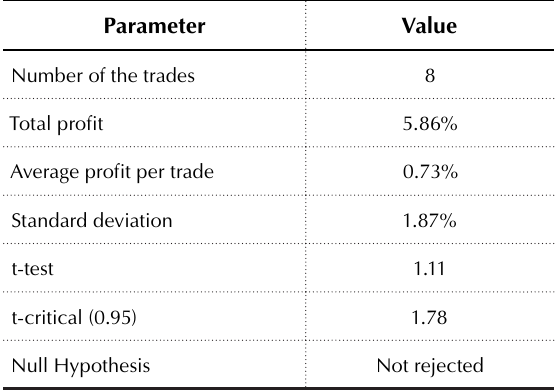
The results of the cumulative abnormal returns